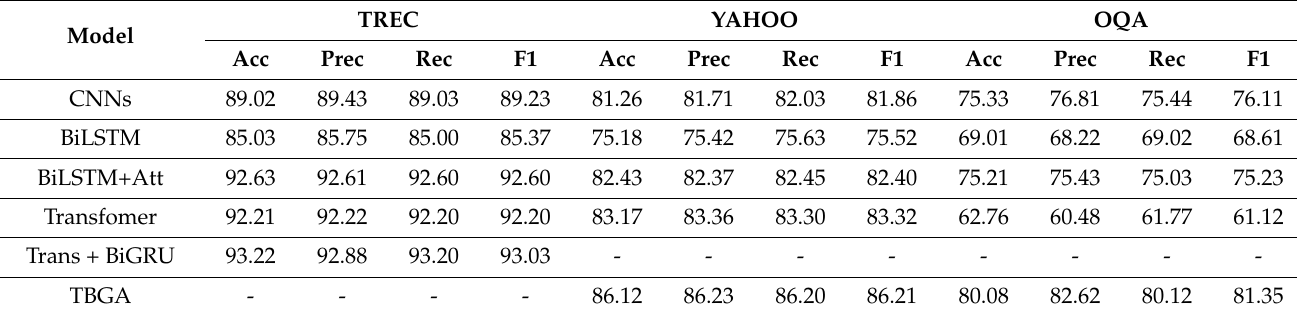
Table 5. Experimental